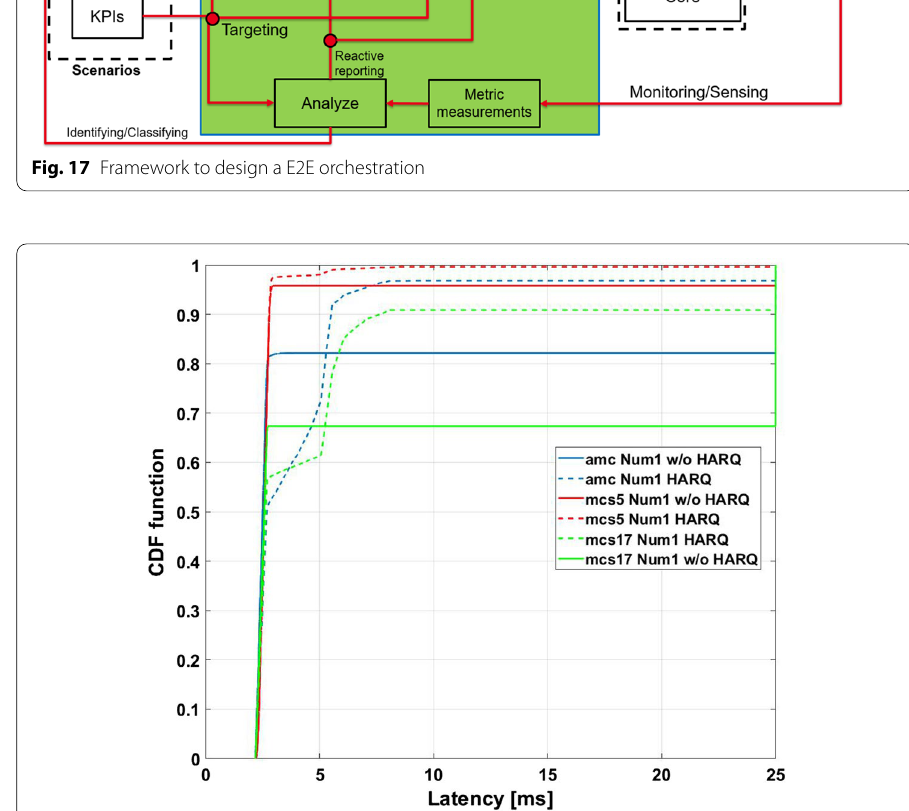
Fig. 18 CDF of E2E latency for MCS5, MCS17 and